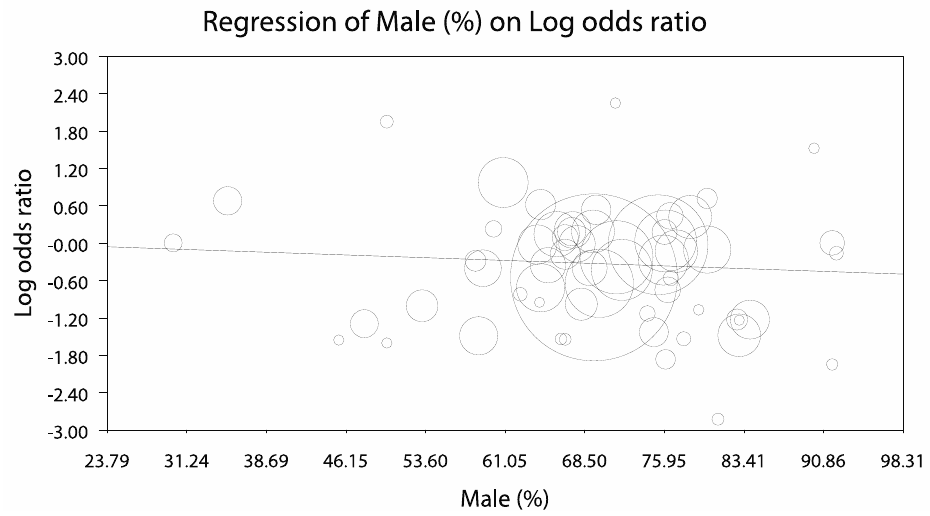
Figure A3. Meta-regression showing the impact of gender distribution on Log odds ratio.